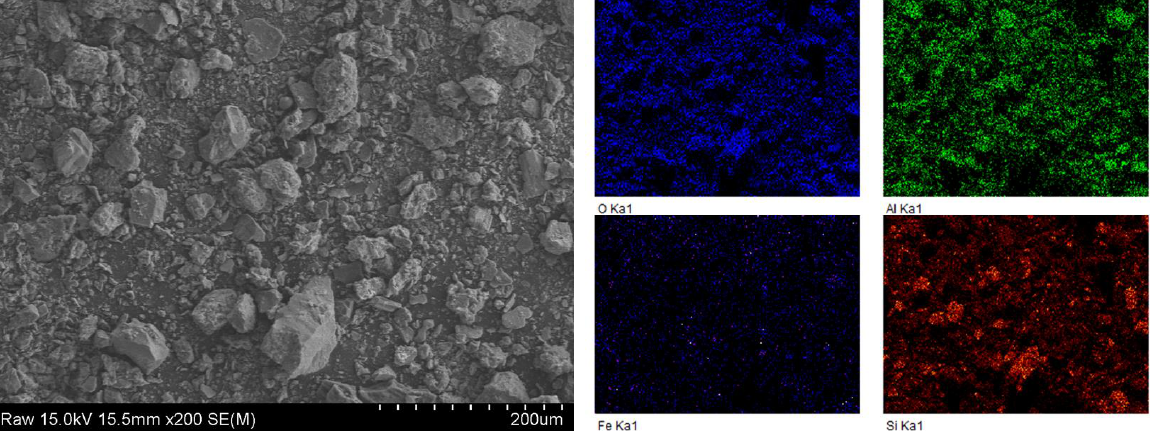
Figure 6. FE-SEM micrograph and corresponding EDS elemental mapping of the contaminated soil.